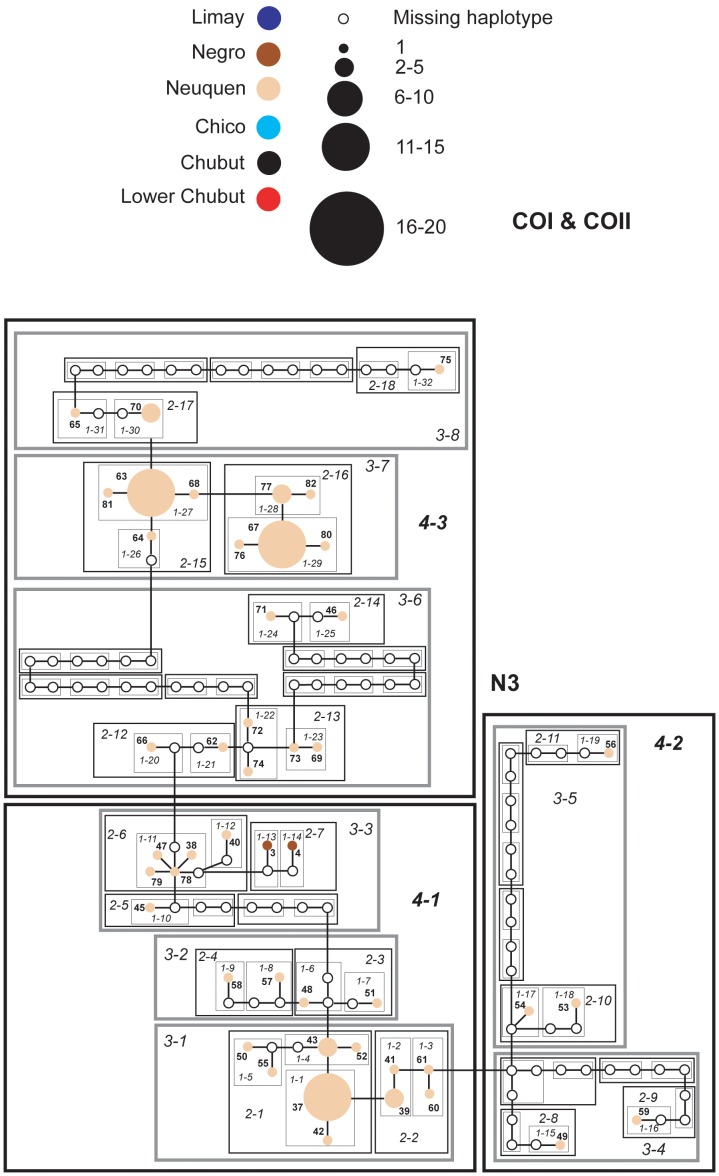
Haplotype networks with nested clade design for mtDNA (COI & COII) sequence data comprised mostly of individuals from the Neuquen River.Haplotype circle size is proportional to its frequency. Each haplotypes is numbered. Haplotypes that exceed twenty individuals are labeled with the total number of individuals of that haplotype. Arrow indicates the root haplotype. Black empty circles represent extinct (or unsampled) haplotypes. Color codes indicate the six major rivers.